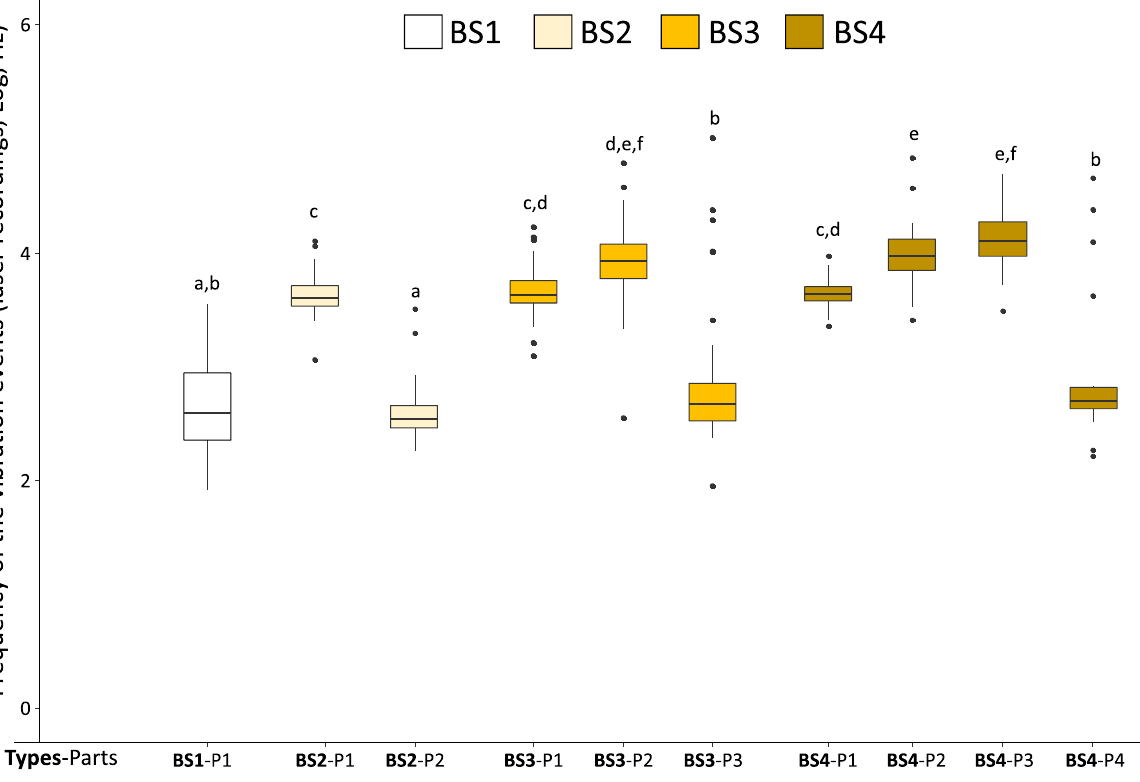
Figure 5. Frequency of the vibration events (laser recordings) for the different types of body-shaking (BS1-4). Within each type of body-shaking (BS1-4), the values are detailed for each of their parts (P1-4; see Fig. S2–S3 for more details on the parts). Significant differences are indicated by different letters ( p < 0.05). Dot indicates